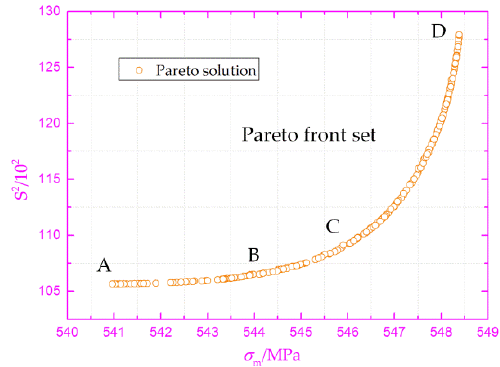
Figure 8. The Pareto front and the optimum Pareto solution.